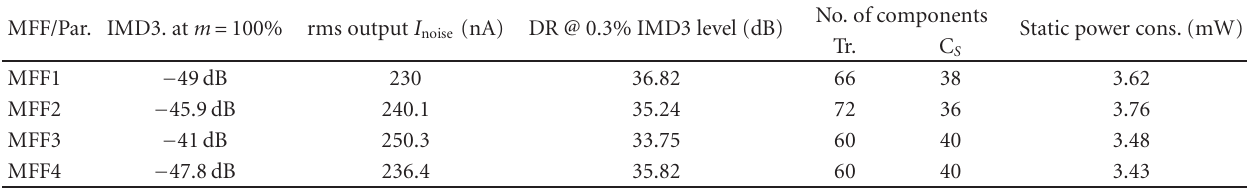
Table 3: Comparison of nonlinearity, component count and power dissipation of MFFs of Figure